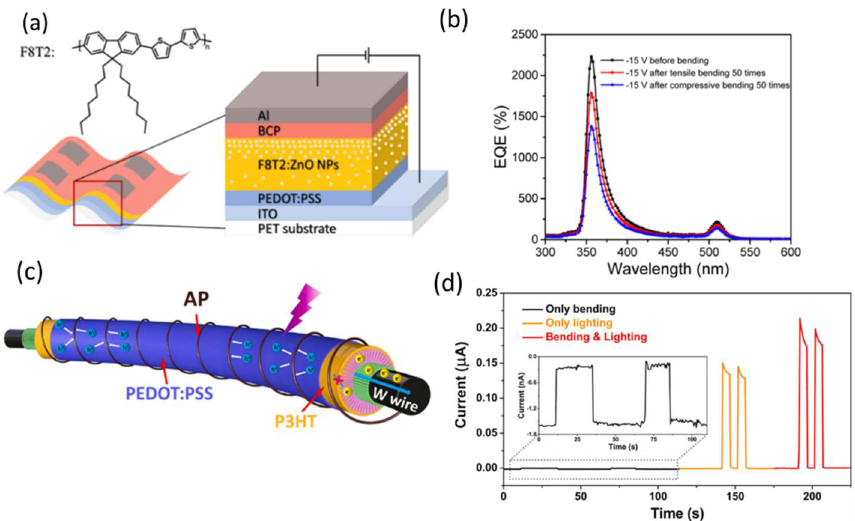
Figure 7. ( a ) Schematic illustration of the flexible narrowband UV PD structure and molecular structure of F8T2, ( b ) EQE spectra of the PD before and after tensile and compressive bending at −15 V bias, reprinted with permission from [129] ©2018 ACS Publications . ( c ) Light-induced carrier transport in fiber-shaped PD based on vertical heterostructure, and ( d ) output current signals of the photodetector under bending, lighting, and lighting + bending, reprinted with permission from [53] ©2021 Elsevier .